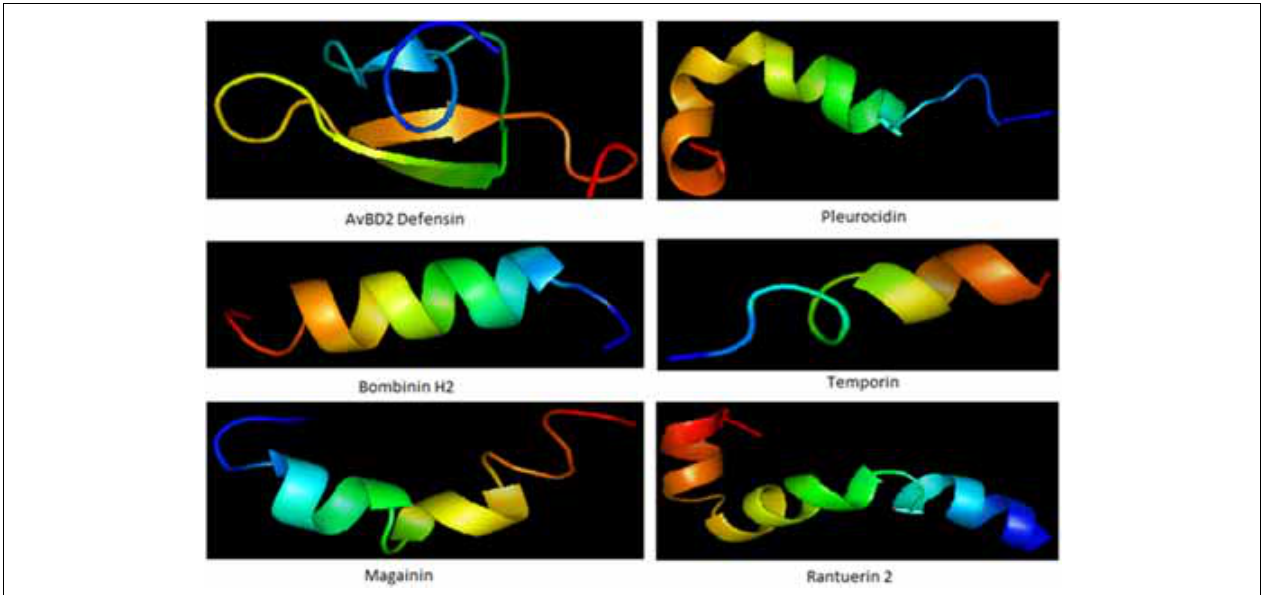
FIGURE 1 | Some representative structure of antimicrobial peptides. Structure represents beta defensin peptide from avian (AvBD2); an amphipathic alpha-helical peptide from skin mucous of Pleuronectes americanus (Pleurocidin); an antimicrobial hemolytic peptide from skin